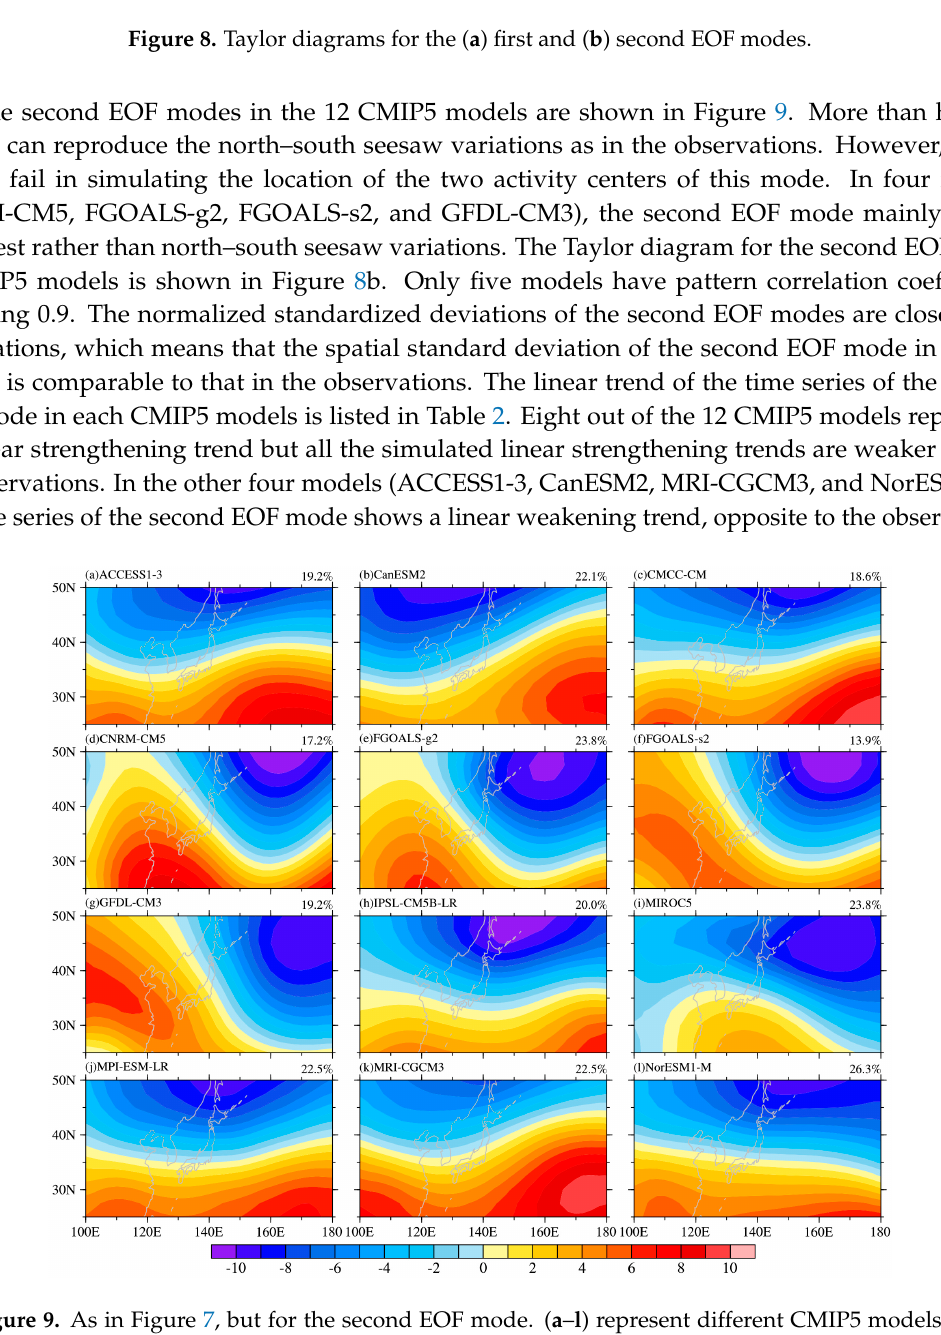
Figure 9. As in Figure 7, but for the second EOF mode. ( a – l ) represent different CMIP5 models as indicated at top left in each panel.